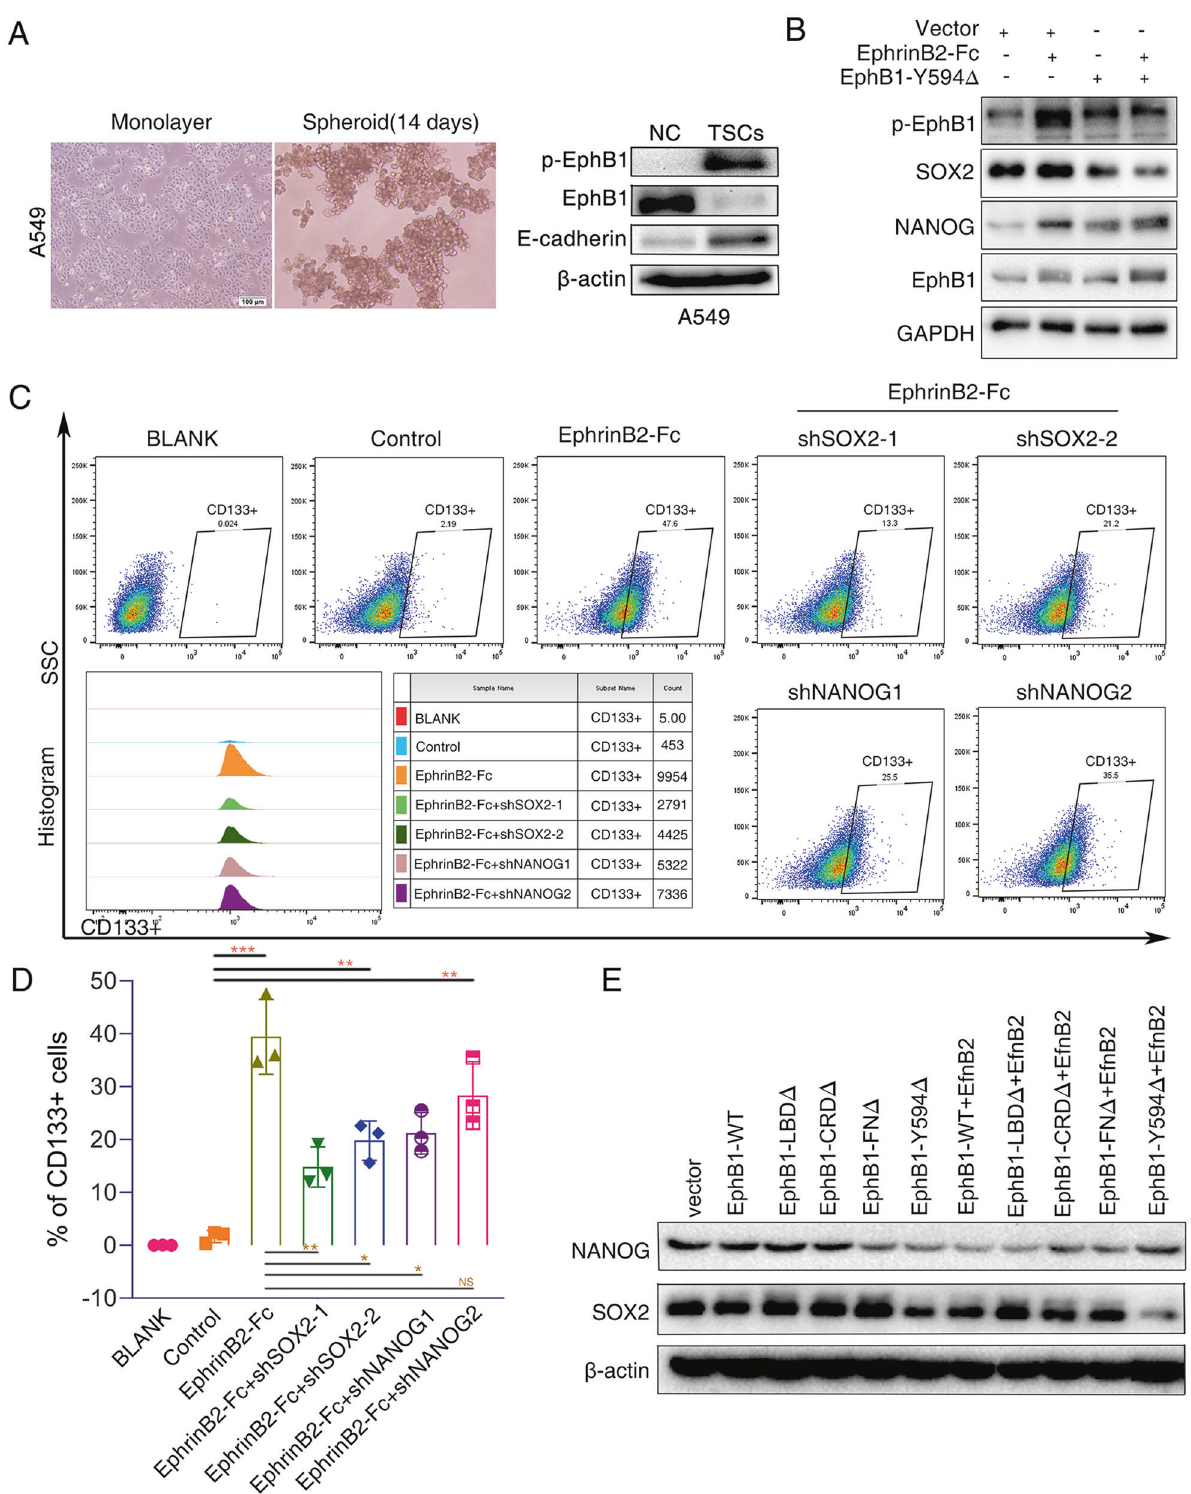
Fig. 8 Trans EphB1 signaling promotes cancer stem cell enrichment. A549 cells were seeded at low density in sphere medium in ultra-low attachment cell plates. Formed spheres were observed after 14 days. A Representative images of sphere-forming cells. Western blot assay was used to evaluate the expression EphB1, p-EphB1 and E-cadherin in sphere-forming cells. B Western blot analysis of cells after treatment of EphrinB2-Fc. C Flow cytometry analysis for stem cell surface marker CD133. The histogram graph was shown in ( D ). E Western blot analysis. The expression of Nanog and Sox2 was evaluated after transfected with EphB1 wt and mutants or Co-transfection of EphB1 and EfnB2.